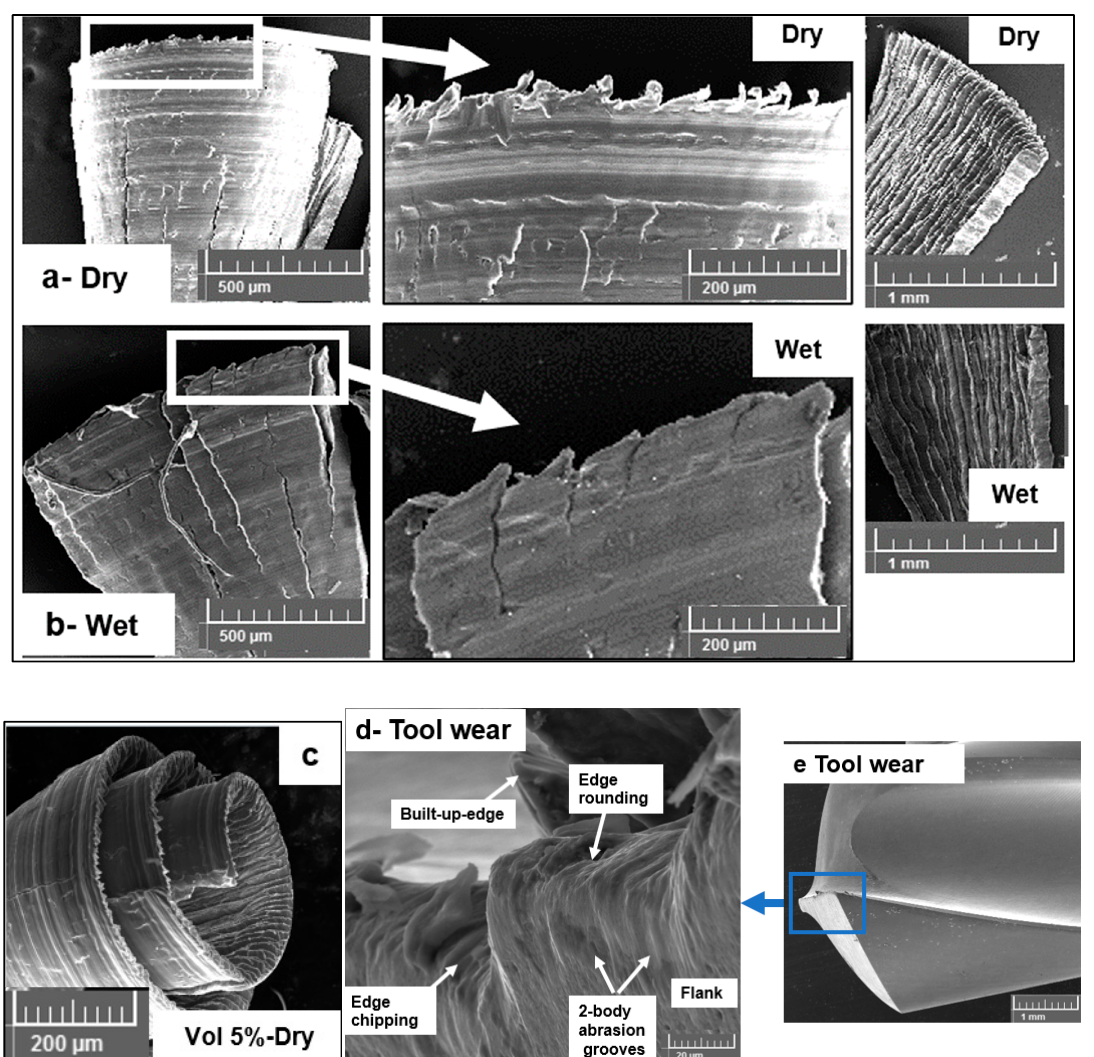
Figure 12. Chip forms during machining AZ31-15% alumina syntactic foam: ( a ) dry cutting, ( b ) wet cutting, ( c ) dry cutting AZ31-5% alumina, ( d , e ) tool-wear during cryocooling.